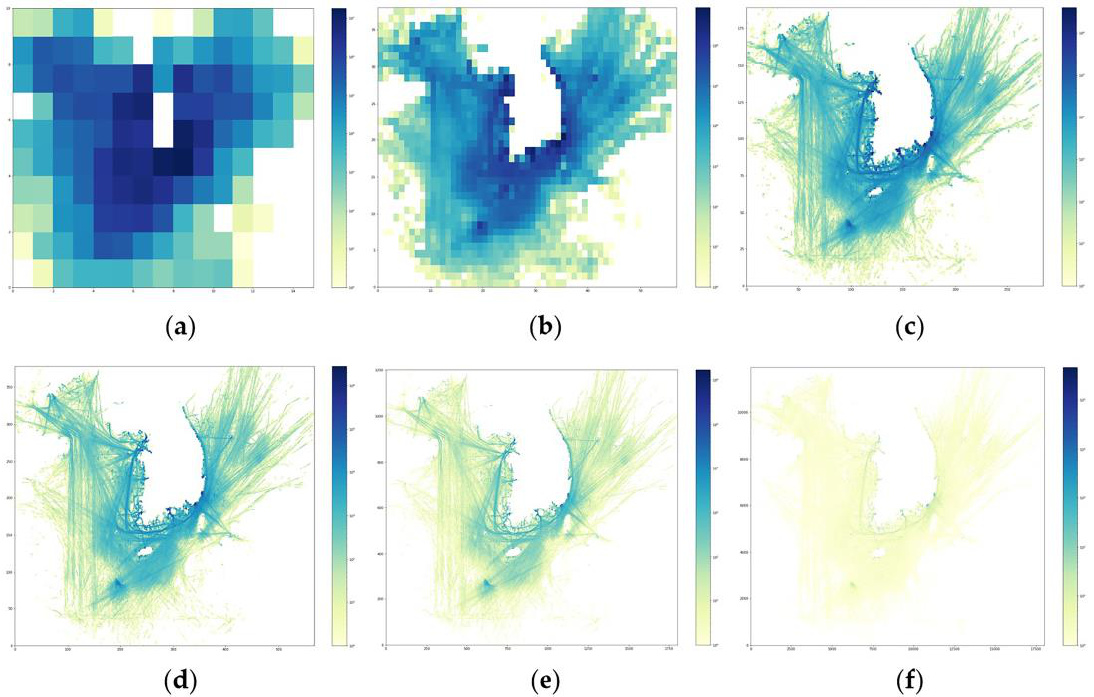
Figure 3. Maritime traffic status by grid level: ( a ) level 1 (1°/abt. 100 km); ( b ) level 2 (15′/abt. 25 km); ( c ) level 3 (3′/abt. 5 km); ( d ) level 4 (1′30″/abt. 2.5 km); ( e ) level 5 (30″/abt. 1 km); ( f ) level 6 (3″/abt. 100 m).